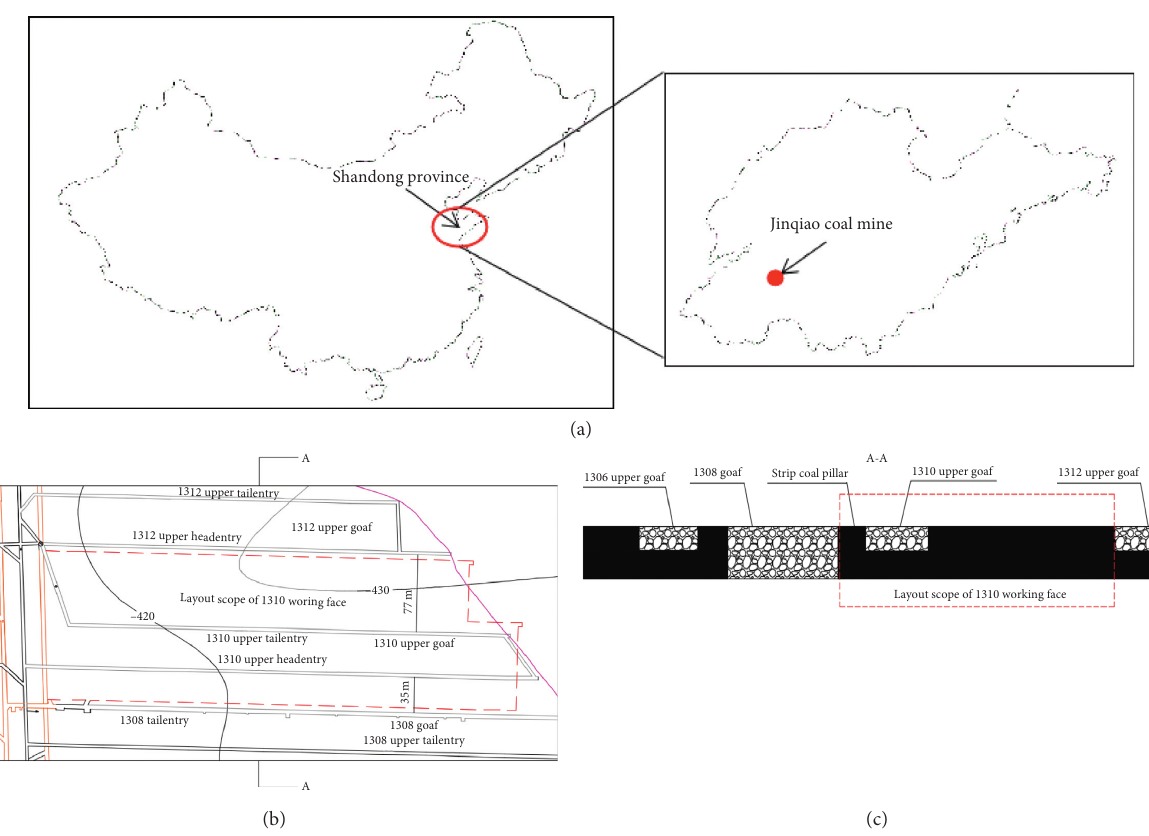
Figure 1: Jinqiao coal mine location and layout scope of 1310 working face.